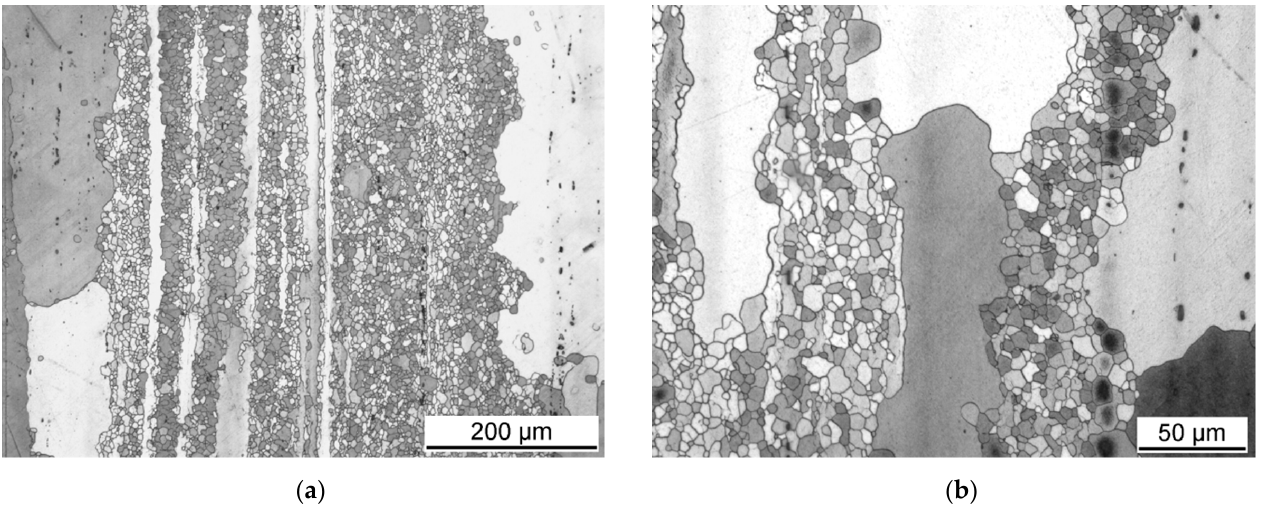
Figure 3. Microstructure of the initial (extruded) condition taken from the section parallel to the extrusion direction ( a ), with higher magnification of the same place ( b ).